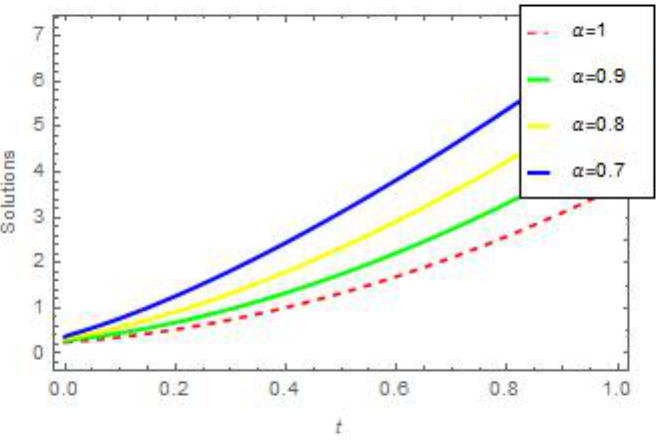
Figure 7. Outcome of Example 2 for α = 1,0.9,0.8,0.7 at n = 2 and x =